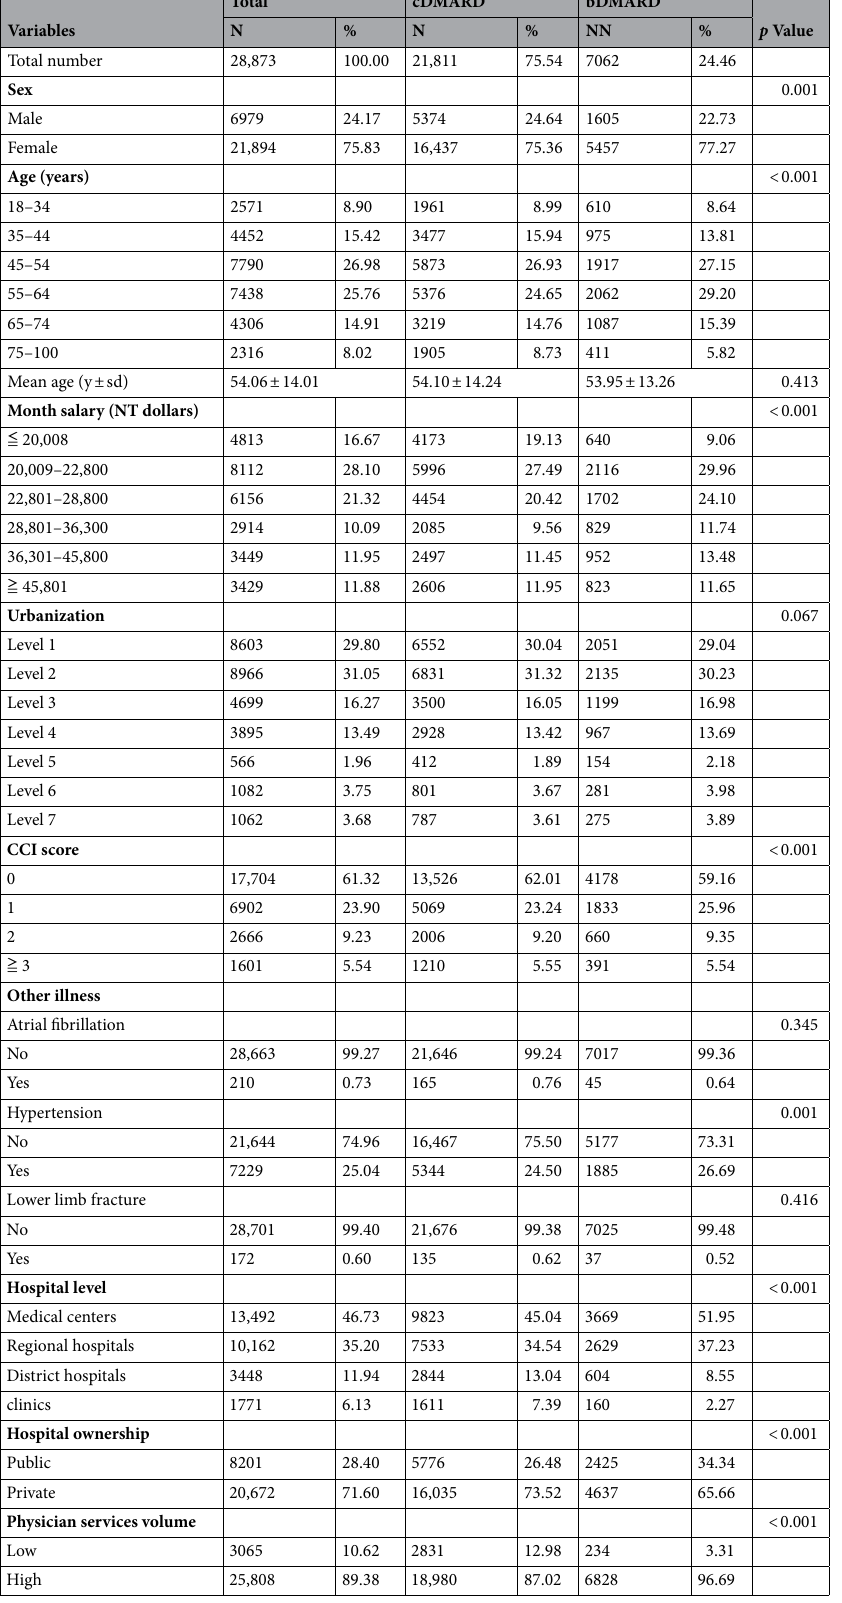
Table 1. Characteristics of RA patients using different DMARDs. N = number, y = years, sd = standard deviation, NT dollars = New Taiwan dollars. CCI is Charlson Comorbidity